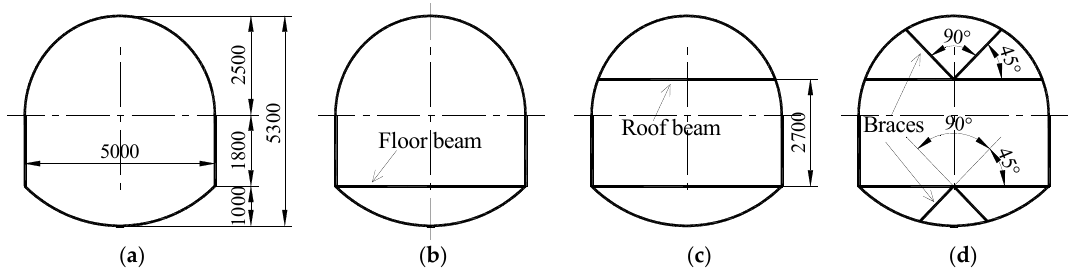
Figure 3. Full-scale sets (units: mm): ( a ) original set; ( b ) floor beam set; ( c ) roof + floor beams set; and, ( d ) roof + floor beams + braces set.